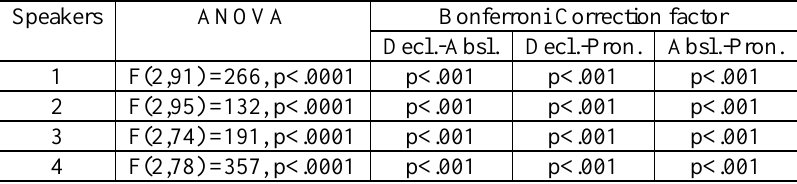
Table 2. Statistical comparisons between the prenuclear High tones of the three utterance types, ANOVA and the Bonferroni correction factor. Sentence types (declarative, absolute interrogative, and pronominal interrogative) were independent factors and the prenuclear High tonal value was the dependent